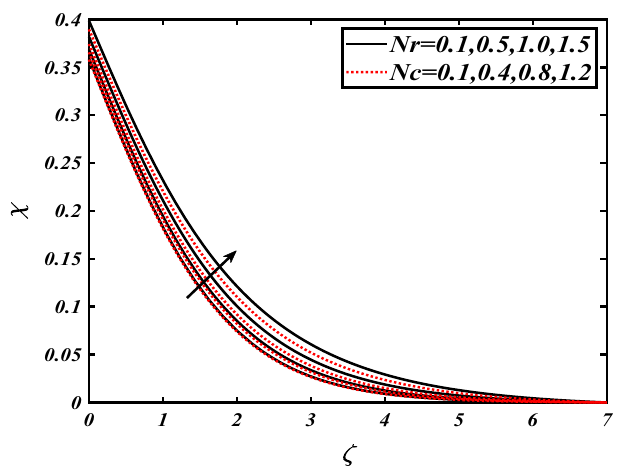
Figure 14. Illustration of Nr and Nc over motile microorganisms χ when Rd = 0.4, γ 2 = 0.3, γ 1 = 0.3, Nr = 0.2, S = 0.5, (cid:31) = 0.5, Pe = 0.1, Lb = 2.0 .